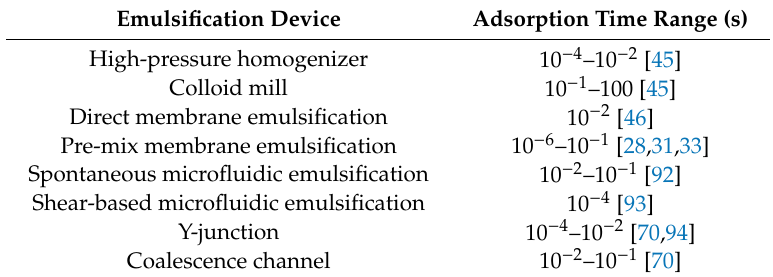
Table 5. Adsorption time range of various emulsification devices and of the used microfluidic devices ([70]; reprinted with permission from the